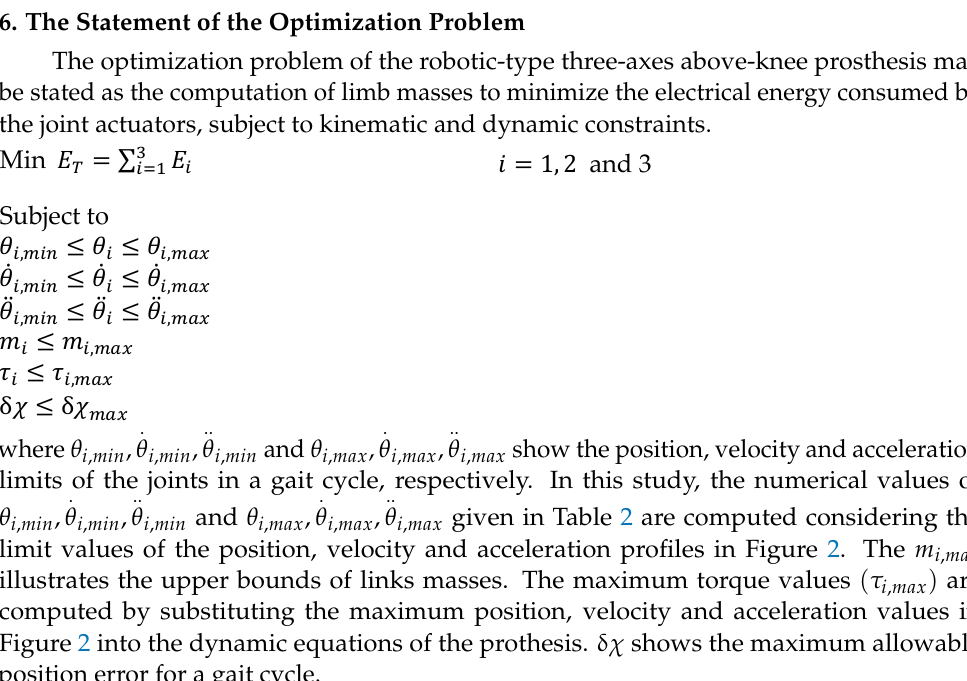
Table 3. Link mass values considering infill density and pattern of the prosthesis shell